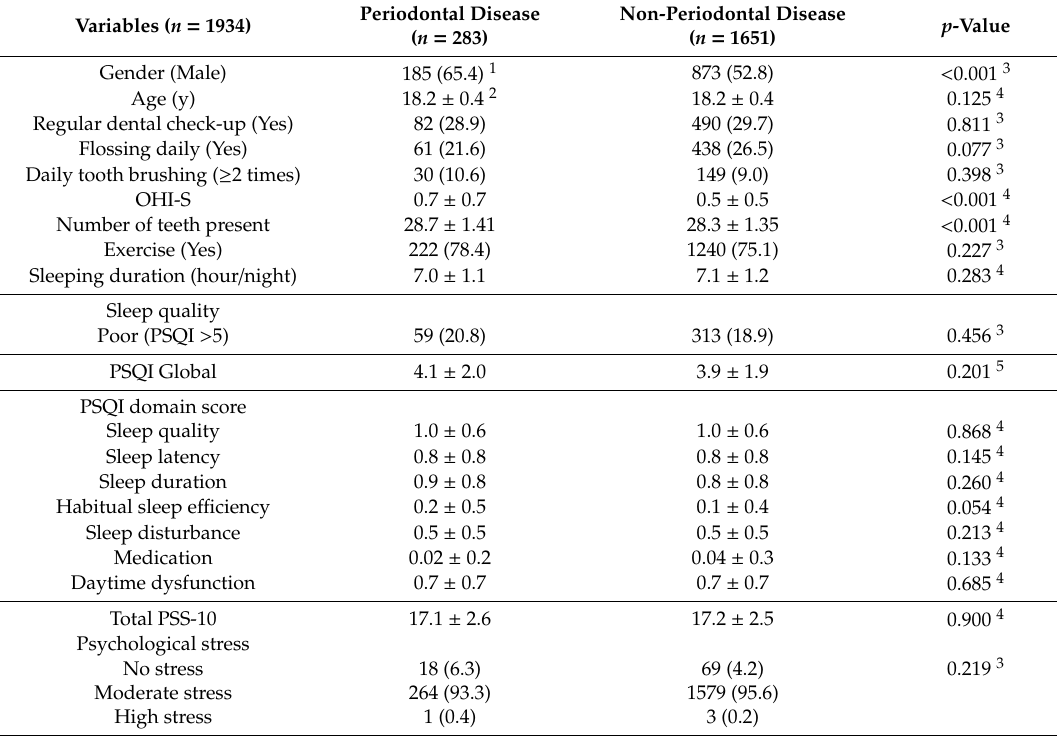
Table 2. Comparison between periodontal disease and non-periodontal disease groups.